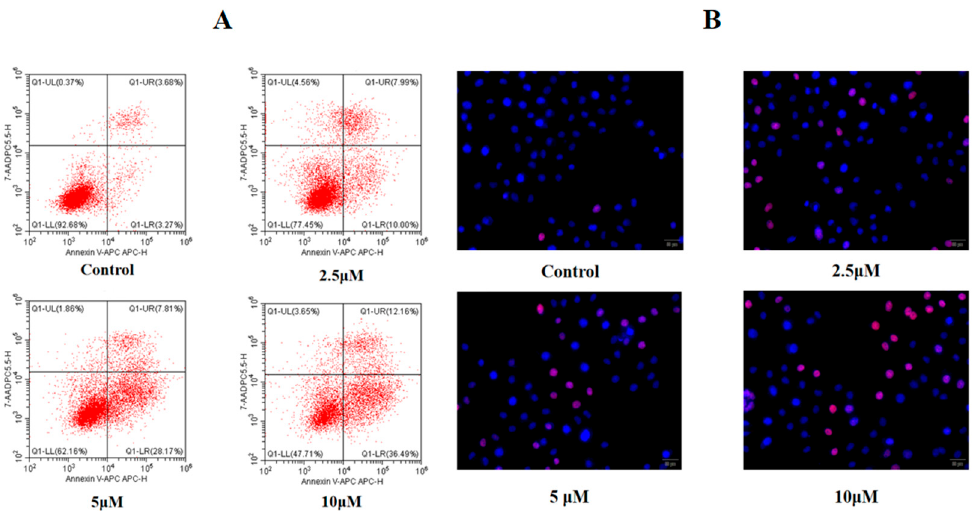
Figure 3. Apoptosis effects on MCF-7 cells induced by A8 . ( A ) A8 -induced apoptosis in MCF-7 cells. MCF-7 cells were incubated with varying concentrations of A8 . After 48 h of incubation, cells were collected and stained with Annexin V/PI, followed by flow cytometric analysis. ( B ) Cell morphological alteration and nuclear change associated with MCF-7 cells after treatment with varying concentrations of A8 were assessed by TUNEL staining and visualized by fluorescence microscopy. Bars denote 50 µ